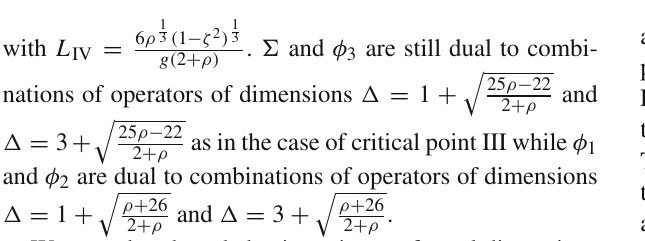
. In this solution, φ 1 = φ 2 = 1 2